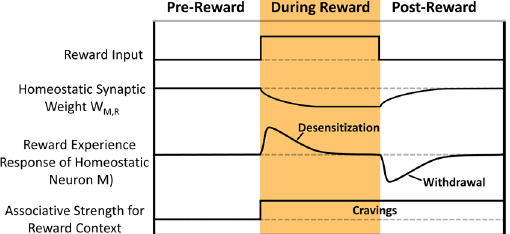
Figure 6. Effects of homeostatic plasticity in addiction. During reward input like Drug consumption, synaptic weight W changes dynamically based on the activity of neurons M and R (q.v. Fig. 1). The response of neuron M to reward input desensitizes during prolonged reward input, and markedly decreases in withdrawal after loss of reward input. If reward input is paired with a stimulus such as Drug odor, after cessation of reward input the associative strength (incentive) for that stimulus remains high. This causes prolonged cravings for the high reward stimulus after completion of